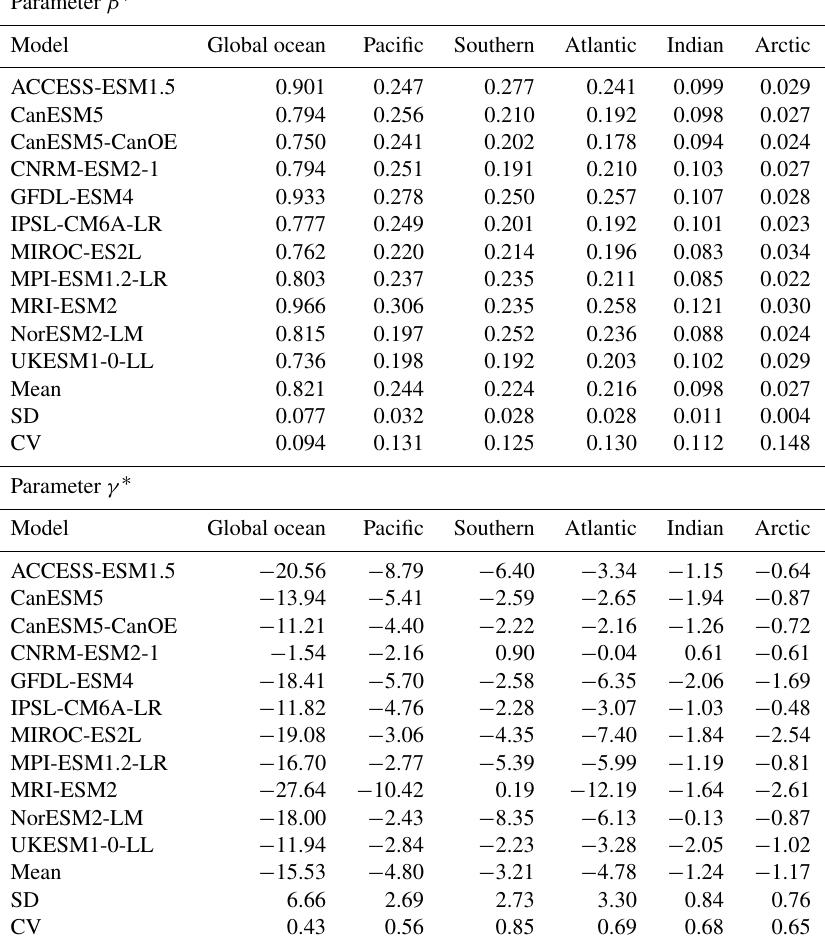
Table 2. Carbon–concentration feedback parameter based on carbon storage, β ∗ (PgCppm − 1 ), and carbon–climate feedback parameter based on carbon storage, γ ∗ (PgCK − 1 ), for the global ocean and different ocean basins in 11 CMIP6 Earth system models, along with the inter- model mean; standard deviation; and coefficient of variation (CV), estimated as the standard deviation divided by the mean. The estimates are based on the fully coupled simulation (COU) and the biogeochemically coupled simulation (BGC) under the 1%yr − 1 increasing CO 2 experiment. Diagnostics are from years 121 to 140 (the 20 years up to quadrupling of atmospheric CO 2 ). Note that for the global ocean, β ∗ and γ ∗ are equivalent to β and γ